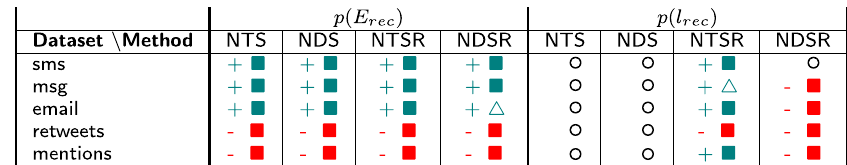
Table 2 Null models identify memory as a mechanism for reciprocity. Signed (one-tailed) p -values of the temporal reciprocity measures p ( E rec ) and p ( l rec ) between the studied datasets and four null models shuffling interaction events. Symbols are (cid:2) ( p < 0.03), (cid:11) (0.03 < p < 1), and filled symbols indicating a statistical significant difference between model and data (significance level α = 0.03). The sign of the p -value is chosen with respect to median values: for positive (green) p -values, empirical measures are higher than the median of shuffling results, and viceversa for the negative (red) p -values (see Additional file 1 Section S4 for details). Null models are denoted by